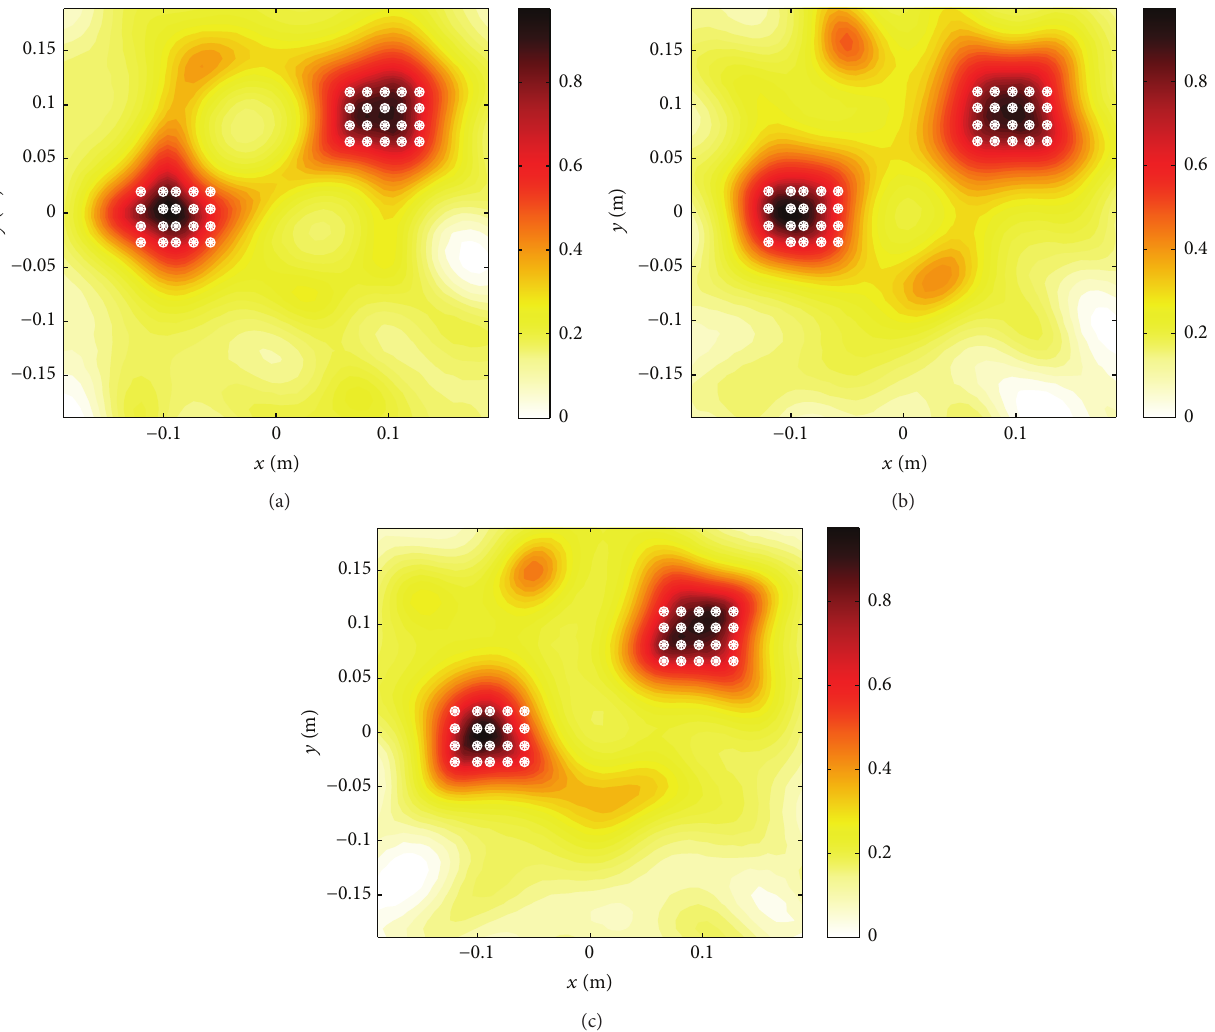
Figure 4: Example 1: LSM reconstructions by using measurement configuration A and corresponding pivot points. (a) Circular scanner, (b) square scanner, and (c) triangular